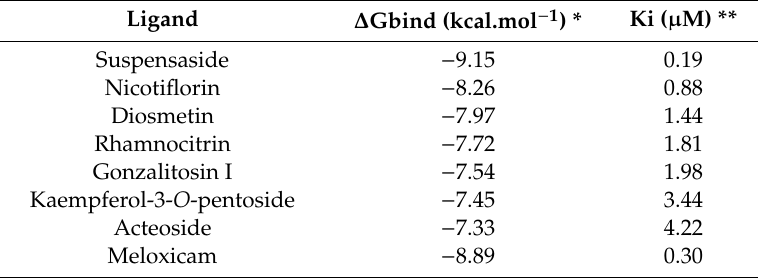
Table 2. Free-binding energies and inhibition constant obtained by molecular docking of the compounds identified in the S. dulcis crude extract with the COX-2 structure.